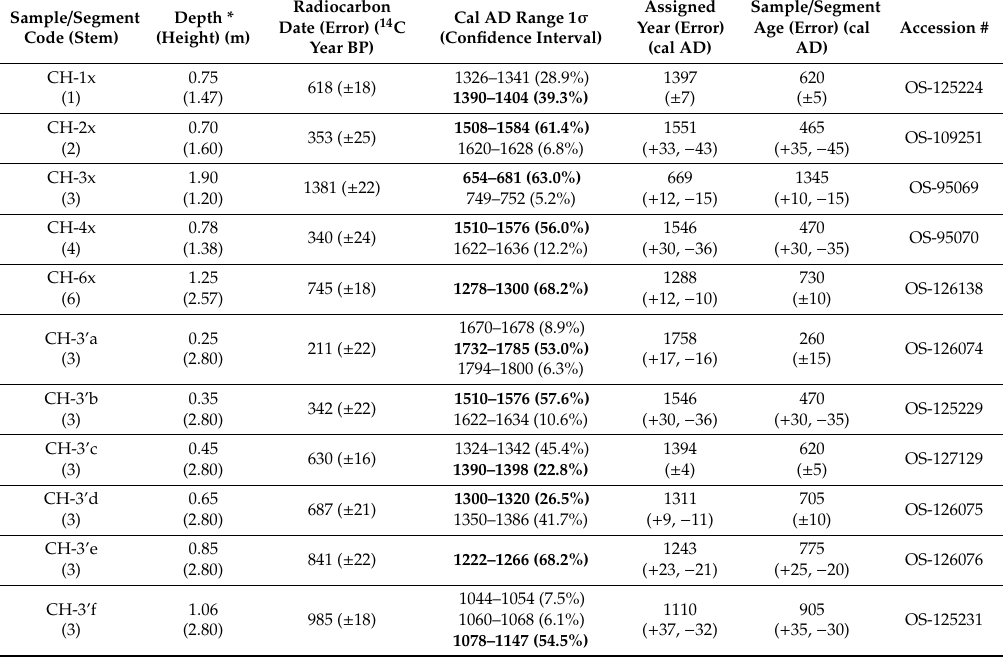
Table 1. Radiocarbon dating results and calibrated ages of sample segments collected from the Chapman